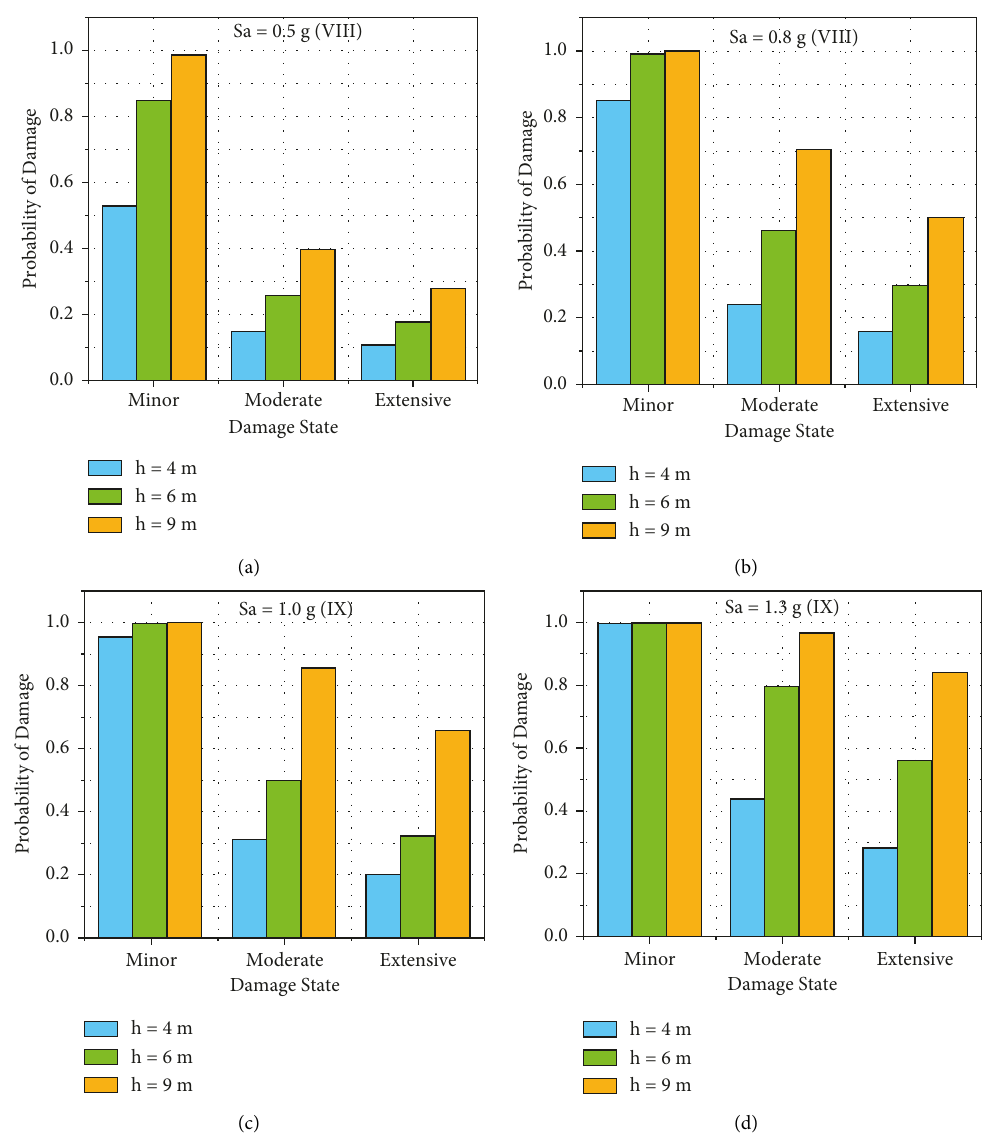
Figure 3: Damage probability for embankment with different heights (P1) for various damage states and seismic